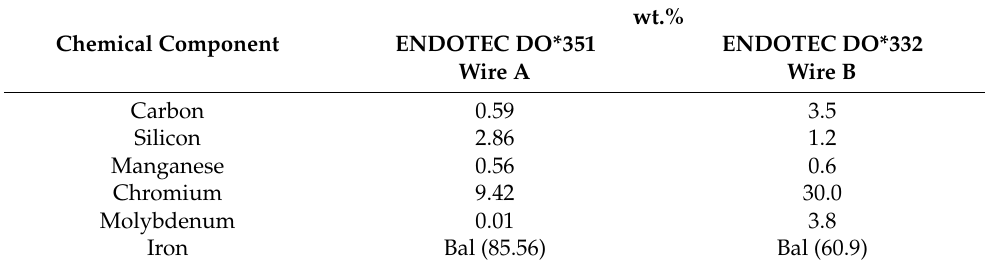
Table 2. Chemical composition of the cored wires, used in this experiment